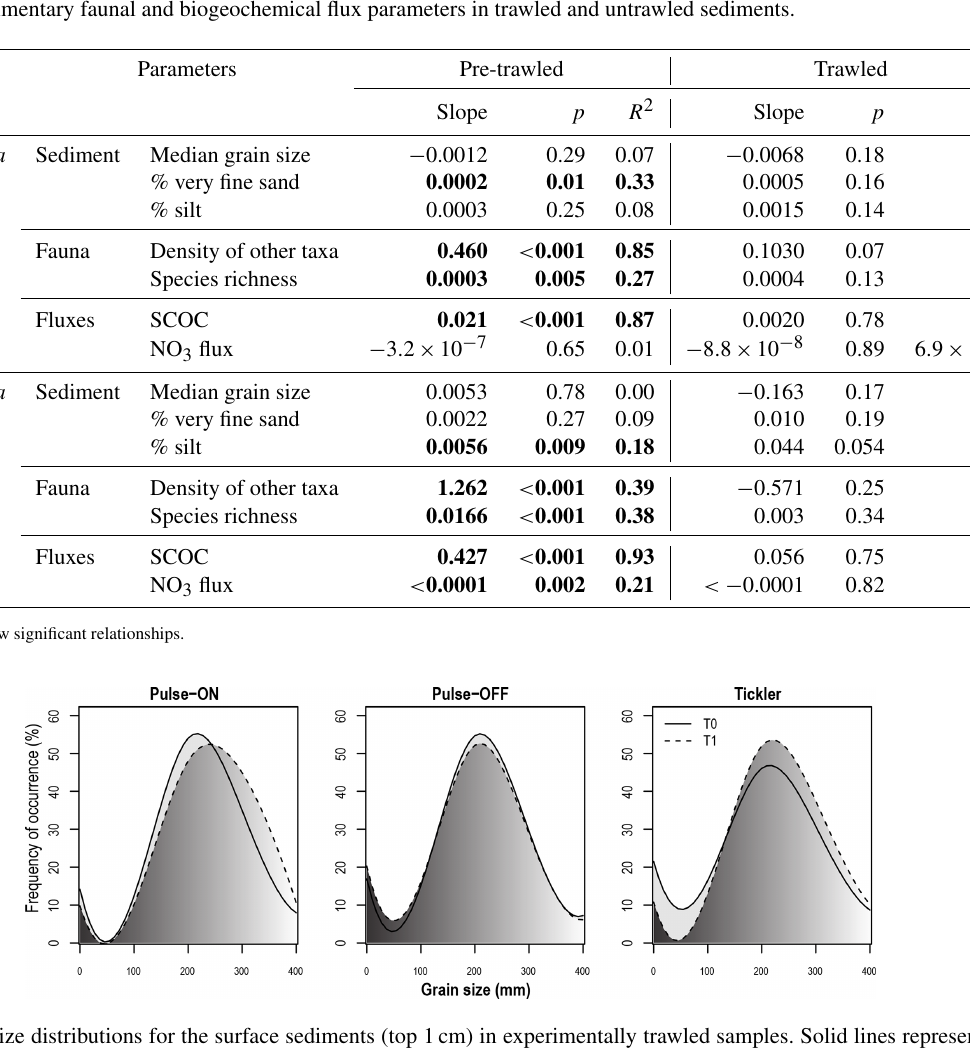
Figure 4. Particle size distributions for the surface sediments (top 1cm) in experimentally trawled samples. Solid lines represent the distri- bution of sediment size fractions in Pulse-ON, Pulse-OFF, and Tickler plots before trawling ( T 0), and dashed lines represent distributions after trawl disturbances ( T